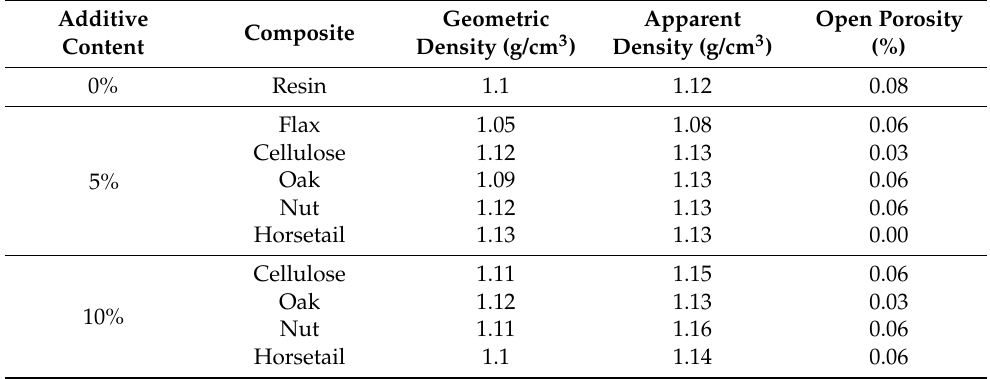
Table 3. Results of the measured